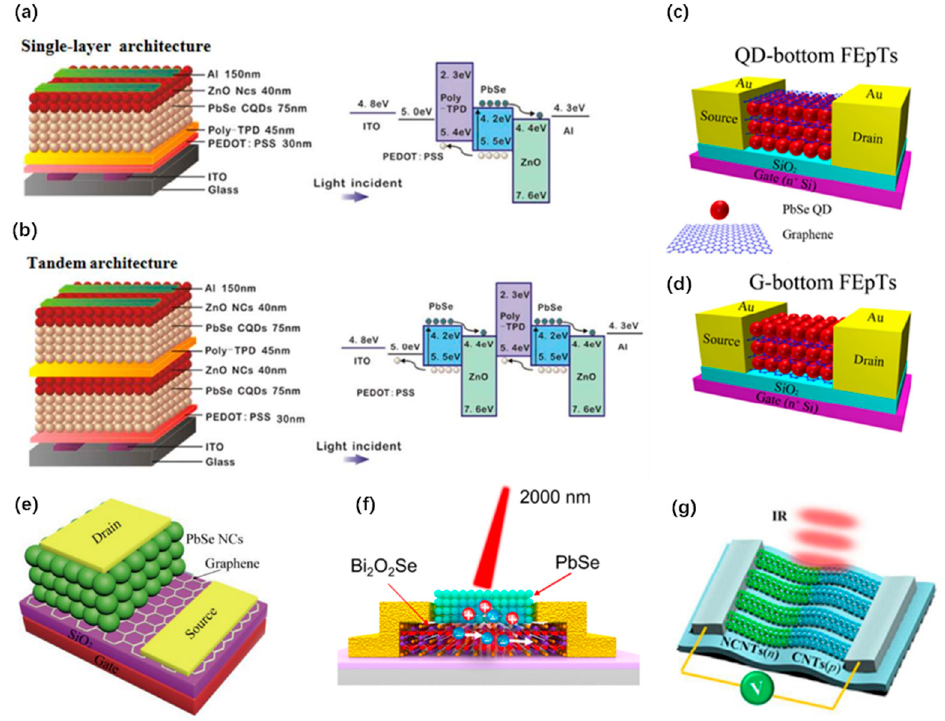
Figure 6. ( a , b ) Device structures and band diagrams of single-layer and tandem photodetectors. Reprinted with permission from Ref. [83]. Copyright 2015 RSC Pub. ( c , d ) Illustrations of QD-bottom FEpTs ( c ) and G-bottom FEpTs ( d ). Reprinted with permission from Ref. [86]. Copyright 2015 American Chemical Society. ( e ) Schematic illustration of PbSe NC-based VPT. Reprinted with permission from Ref. [85]. Copyright 2019 Elsevier. ( f ) Schematic illustration of the PbSe CQD–Bi 2 O 2 Se nanosheet hybrid photodetector. Reprinted with permission from Ref. [87]. Copyright 2019 American Chemical Society. ( g ) Schematic illustration of the detector’s structure. Reprinted with permission from Ref. [80]. Copyright 2016 RSC Pub.